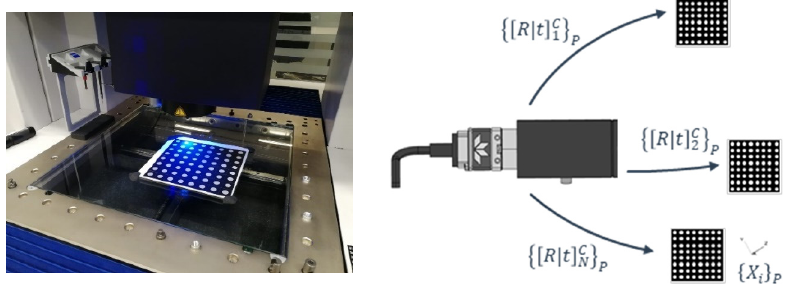
Figure 7. The pre-calibrated pattern ( left ) is located in different positions. In each p position the extrinsic camera parameters are defined and finally, the intrinsic ones are deduced ( right ).